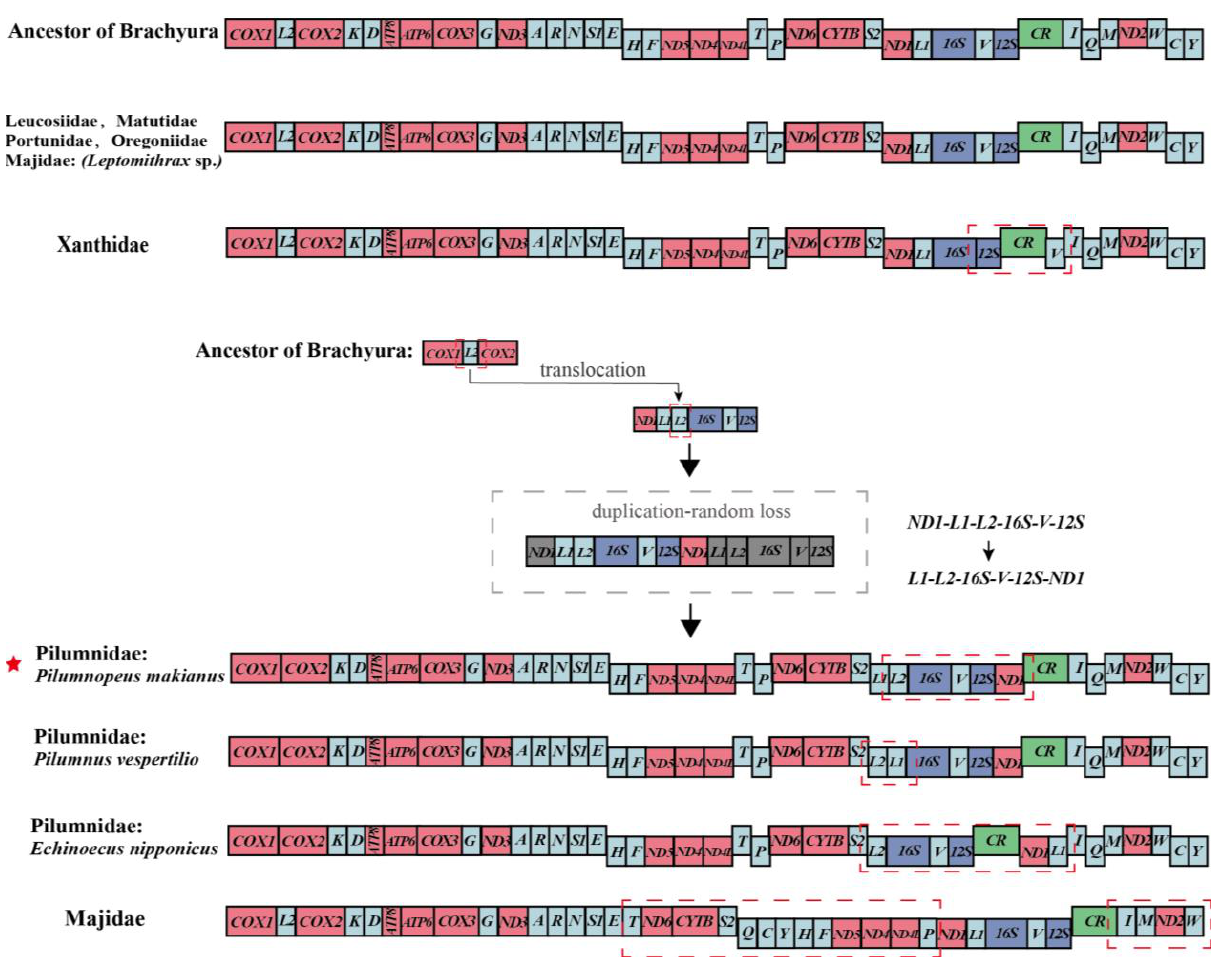
Figure 4. Linear portrayal of gene arrangements of the ancestor Brachyura, P. makianus , and six families in Heterotremata. The single-letter amino acid codes represent corresponding tRNA, and the 16S and 12S are the large and small ribosomal RNA subunits, respectively. The rearranged gene blocks are signed by red gridlines and compared with the gene arrangement of ancestral Brachyura.